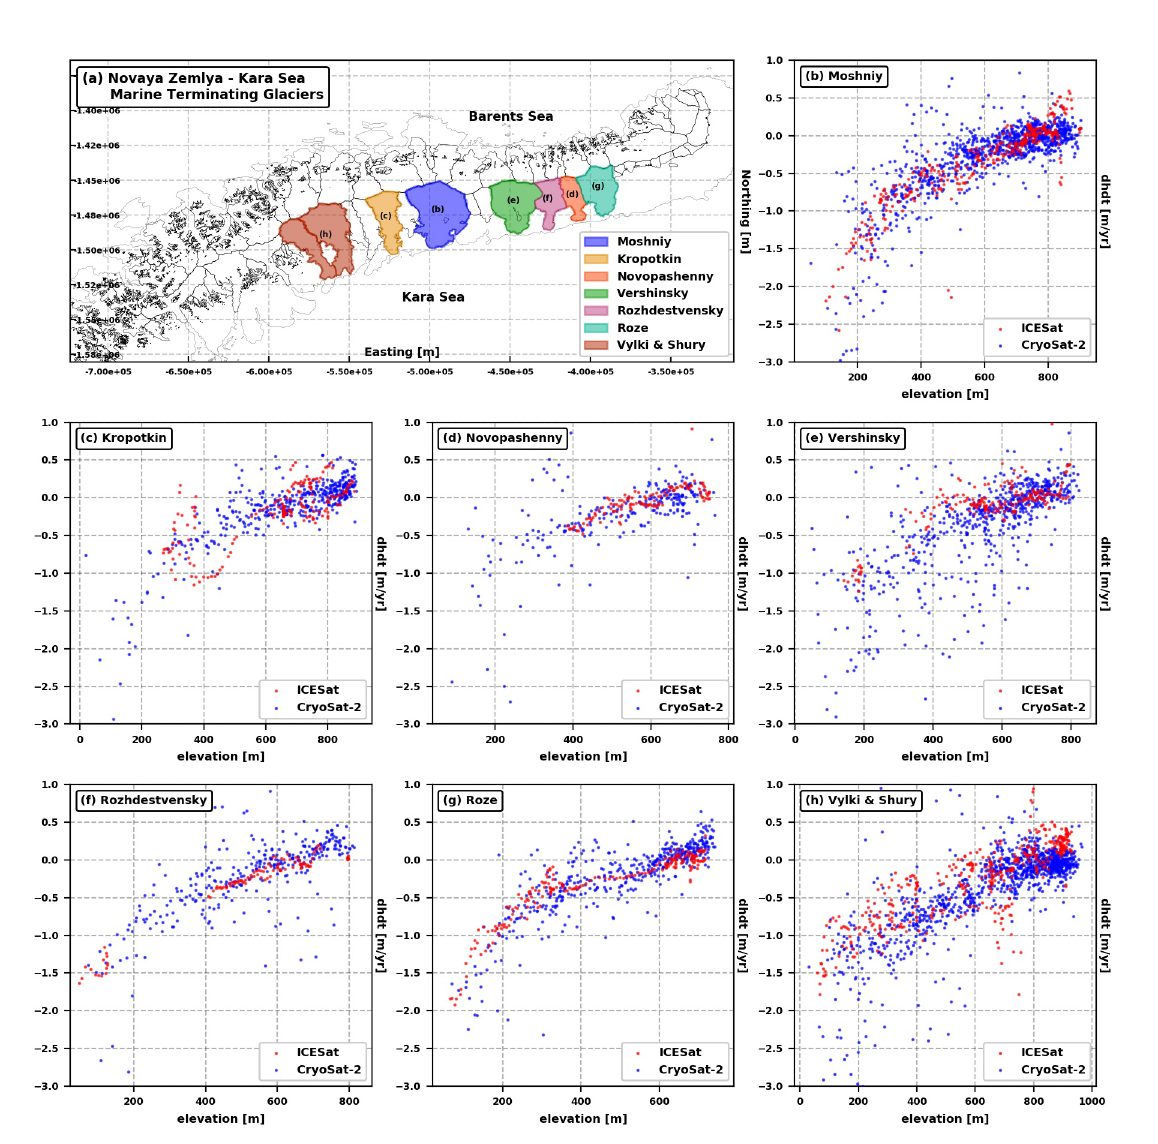
Figure 5. Elevation vs. elevation changes for the major marine-terminating glaciers facing the Kara Sea using ICESat and CryoSat-2. ( a ) Novaya Zemlya Archipelago, ( b ) Moshniy Glacier, ( c ) Koproktin Glacier, ( d ) Navopashenny Glacier, ( e ) Vershinsky Glacier, ( f ) Rozhdestvensky Glacier, ( g ) Roze Glacier, ( h ) Vylki and Shury